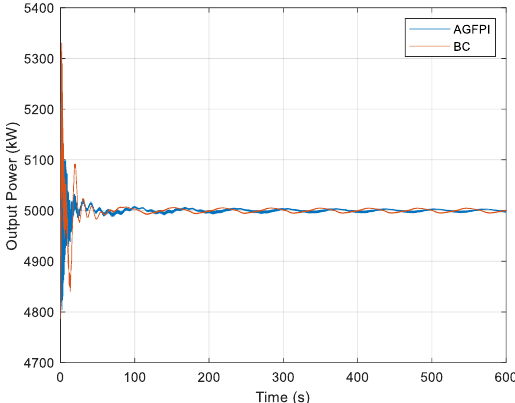
Figure 6. Output power without waves.